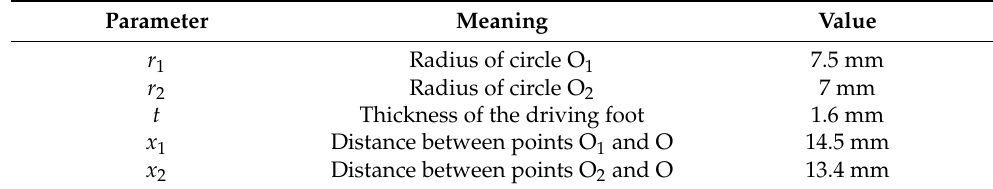
Table 1. The main structural parameters of a quarter of the arc-shaped driving foot.